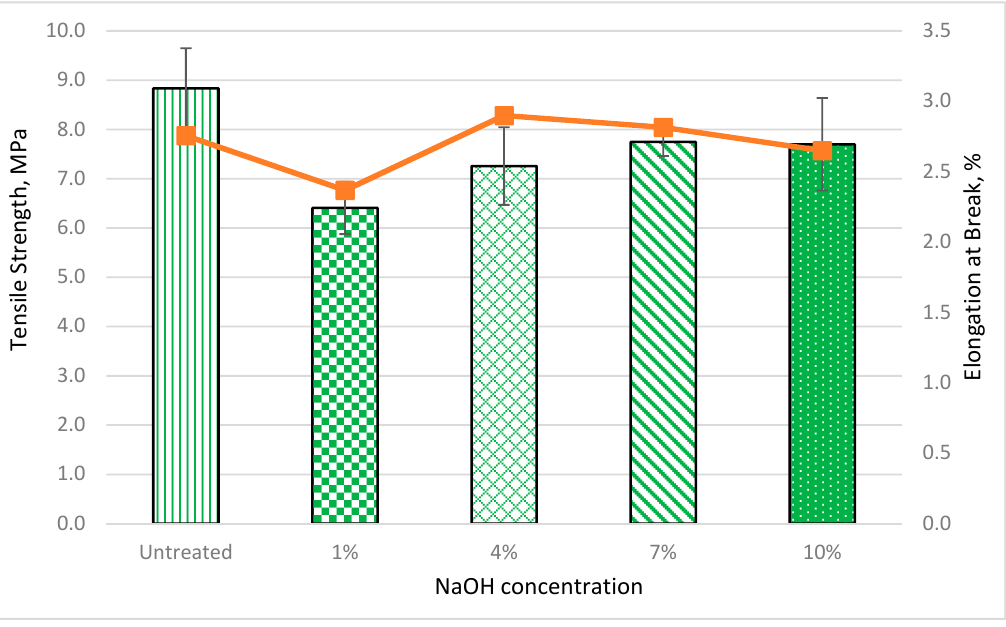
Figure 6. Tensile strength and elongation at break of the composites with different NaOH concentration.